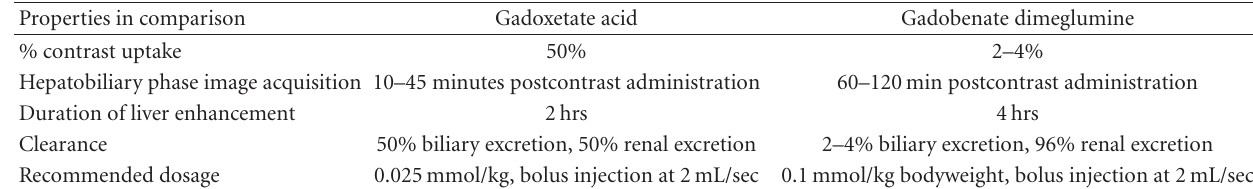
Table 1: Major di ff erences between gadoxetate acid and gadobenate